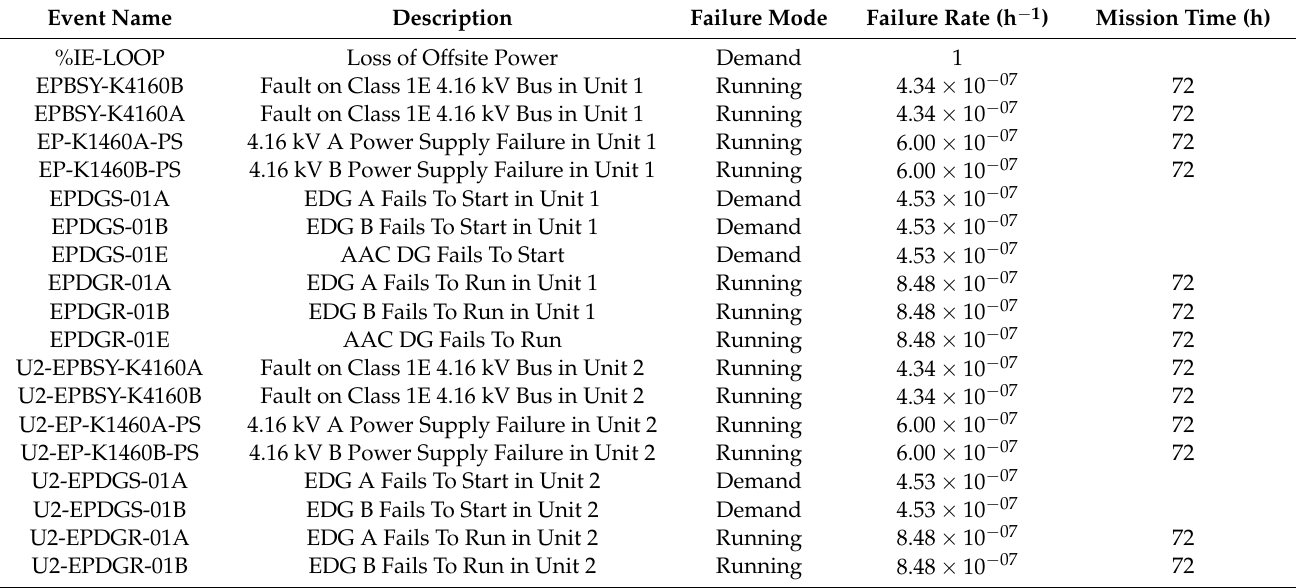
Table 1. Reliability data for constructing the SFT and DFT.